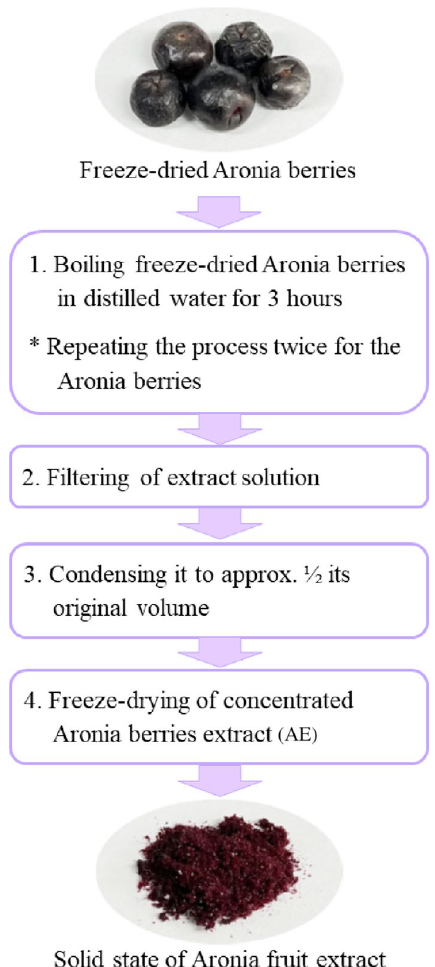
Fig. 1 Schematic process of Aronia berries extract powder